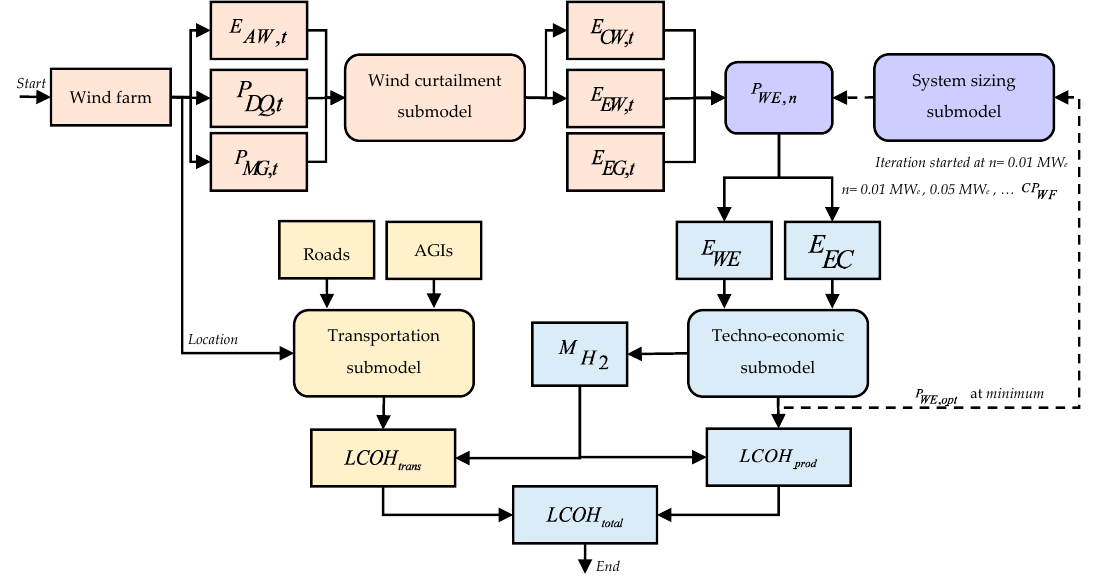
Figure 4. Algorithm to calculate the LCOHtotal .